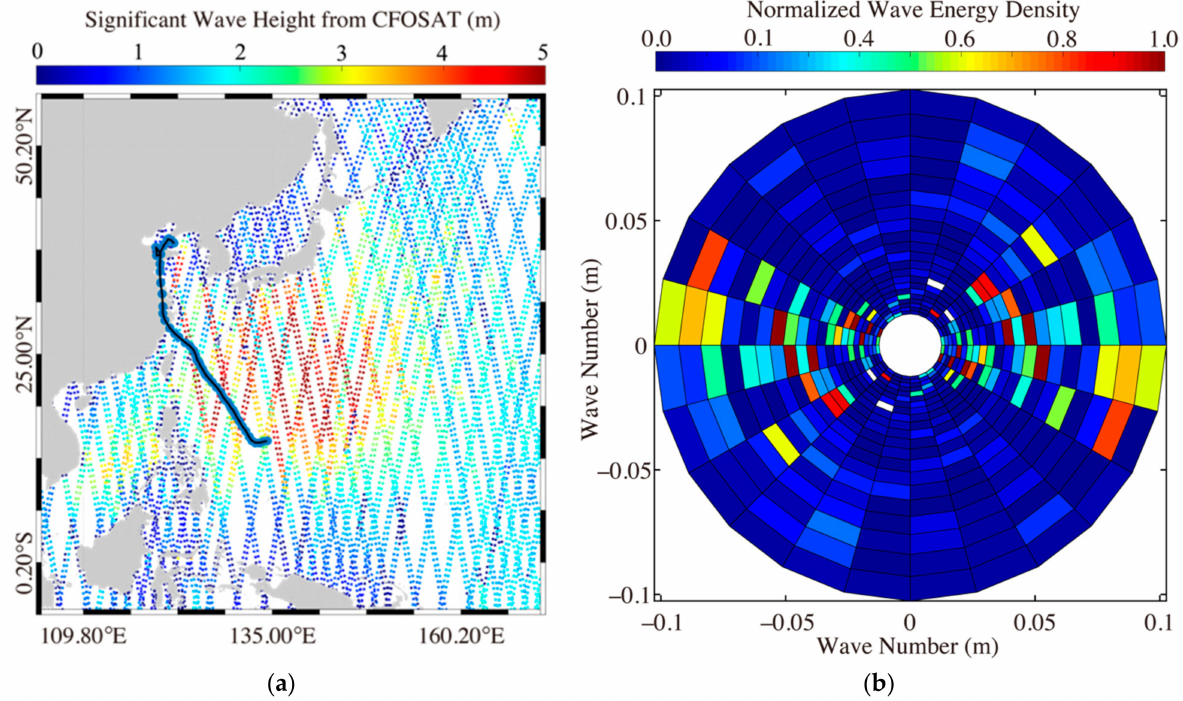
Figure 2. ( a ) The footprints of H s from Surface Wave Investigation and Monitoring (SWIM) onboard the Chinese-French Oceanography SATellite (CFOSAT) satellite with the tracks of Typhoon Lekima (2019). ( b ) The SWIM-measured wave spectrum at 18:58 UTC on 25 April